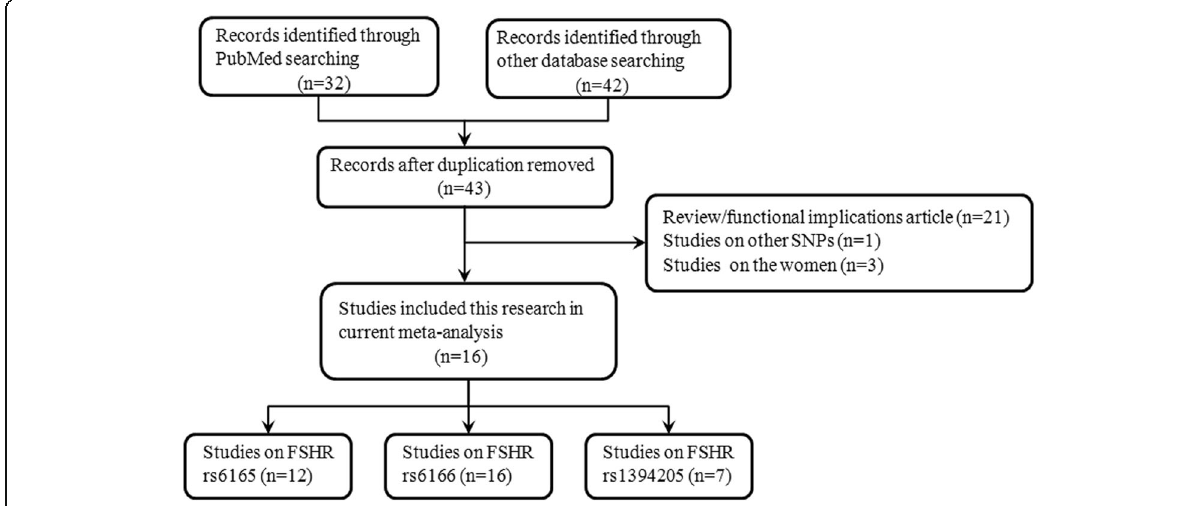
Fig. 1 Flow chart of studies identified with inclusion and exclusion